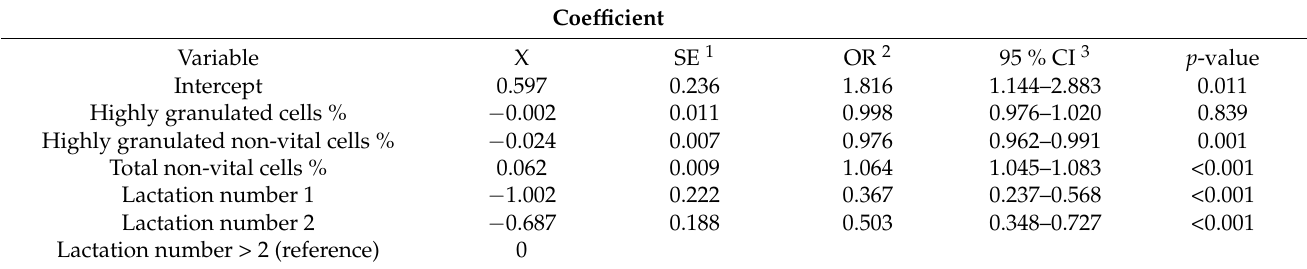
Table 1. Final mixed logistic regression model for the individual ability of cytological cure.